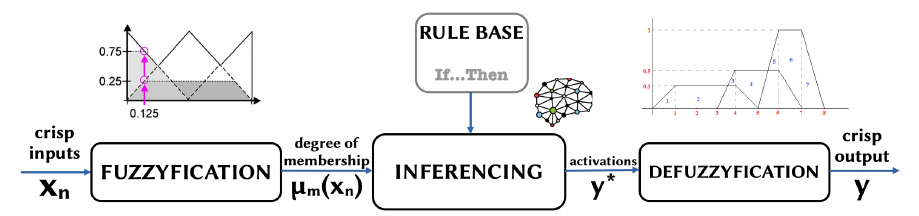
Figure 4. Steps of the fuzzy control